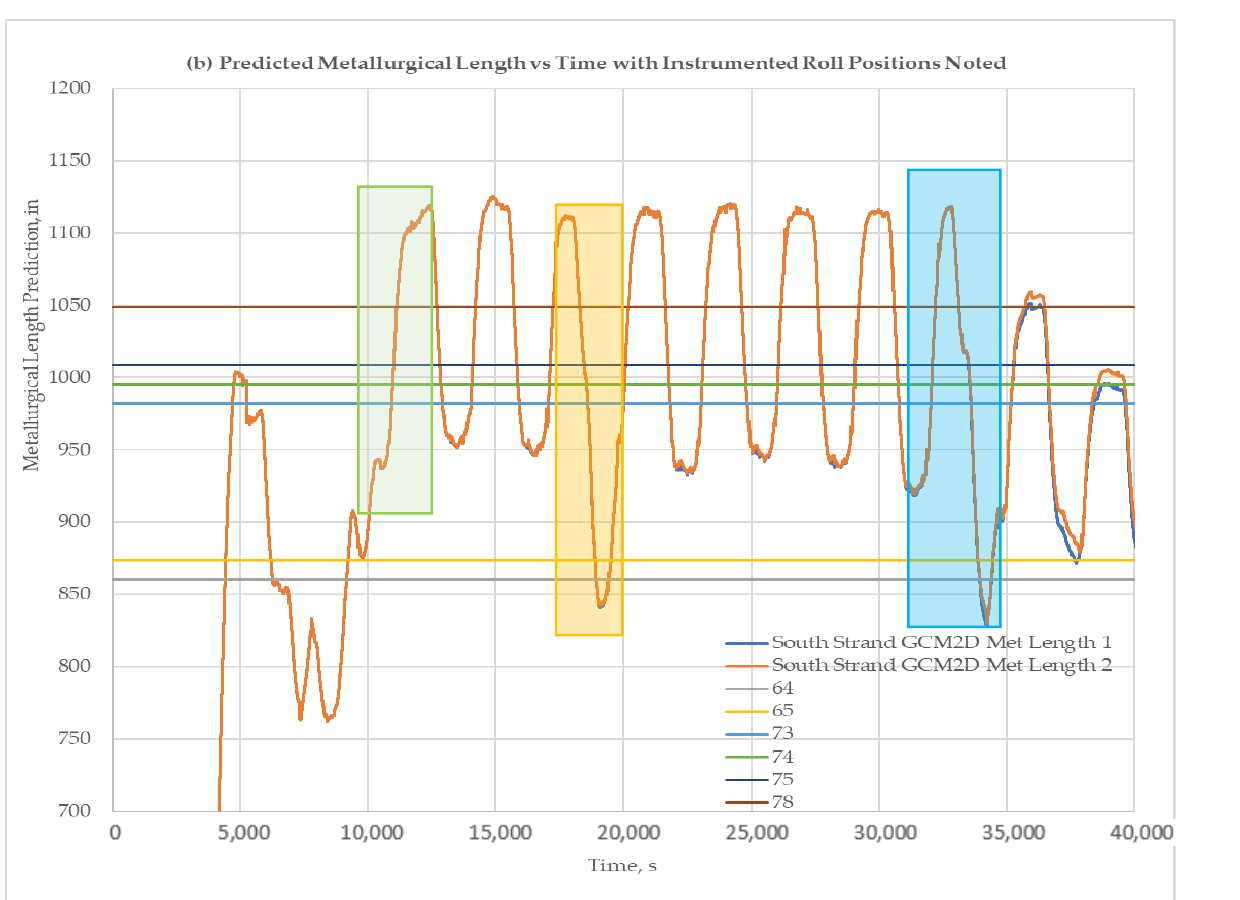
Figure 20. Liquid core position and corresponding net roll strains for the first 12 heats of the 20-heat cast sequence with liquid core locations highlighted for Roll-64 (all roll strains shown). ( a ) Net strain and cast speed is plotted against time. Three sections (highlighted by rectangles) were chosen to be compared with metallurgical length. ( b ) Predicted metallurgical lengths for different time periods. Strain comparison for sections highlighted in Figure 21a with metallurgical lengths.